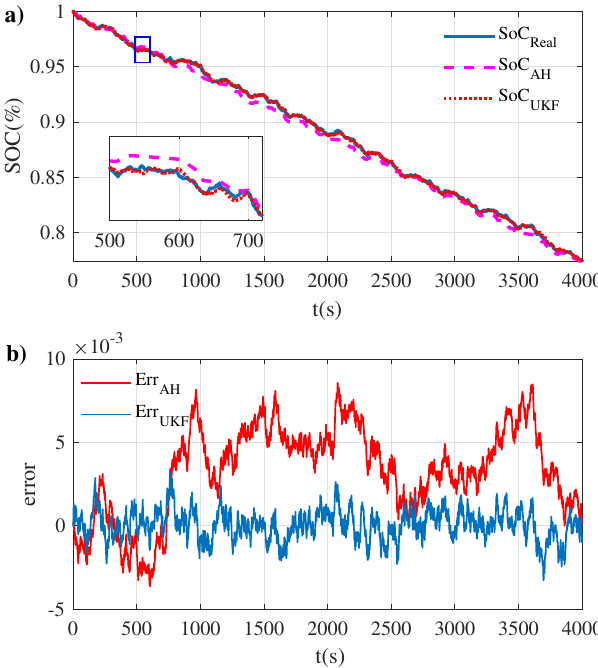
Figure 7. ( a ) SOC estimation curve based on UKF algorithm and ( b )